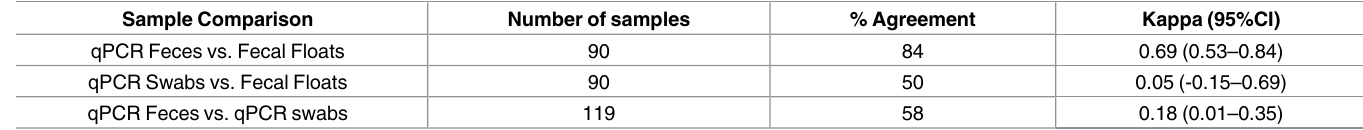
Table 2. Results from quantitative PCR (qPCR) on fecal samples and cloacal and fecal float results from experimentally infected and wild caught northern bobwhites ( Colinus virginianus ). Sample